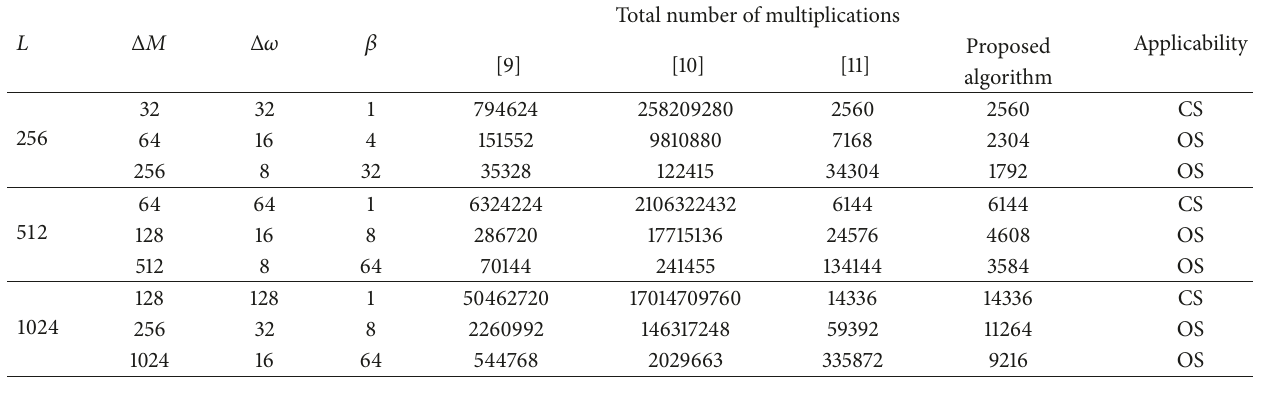
Table 1: Numerical comparison of multiplications between proposed approach and other existing methods.